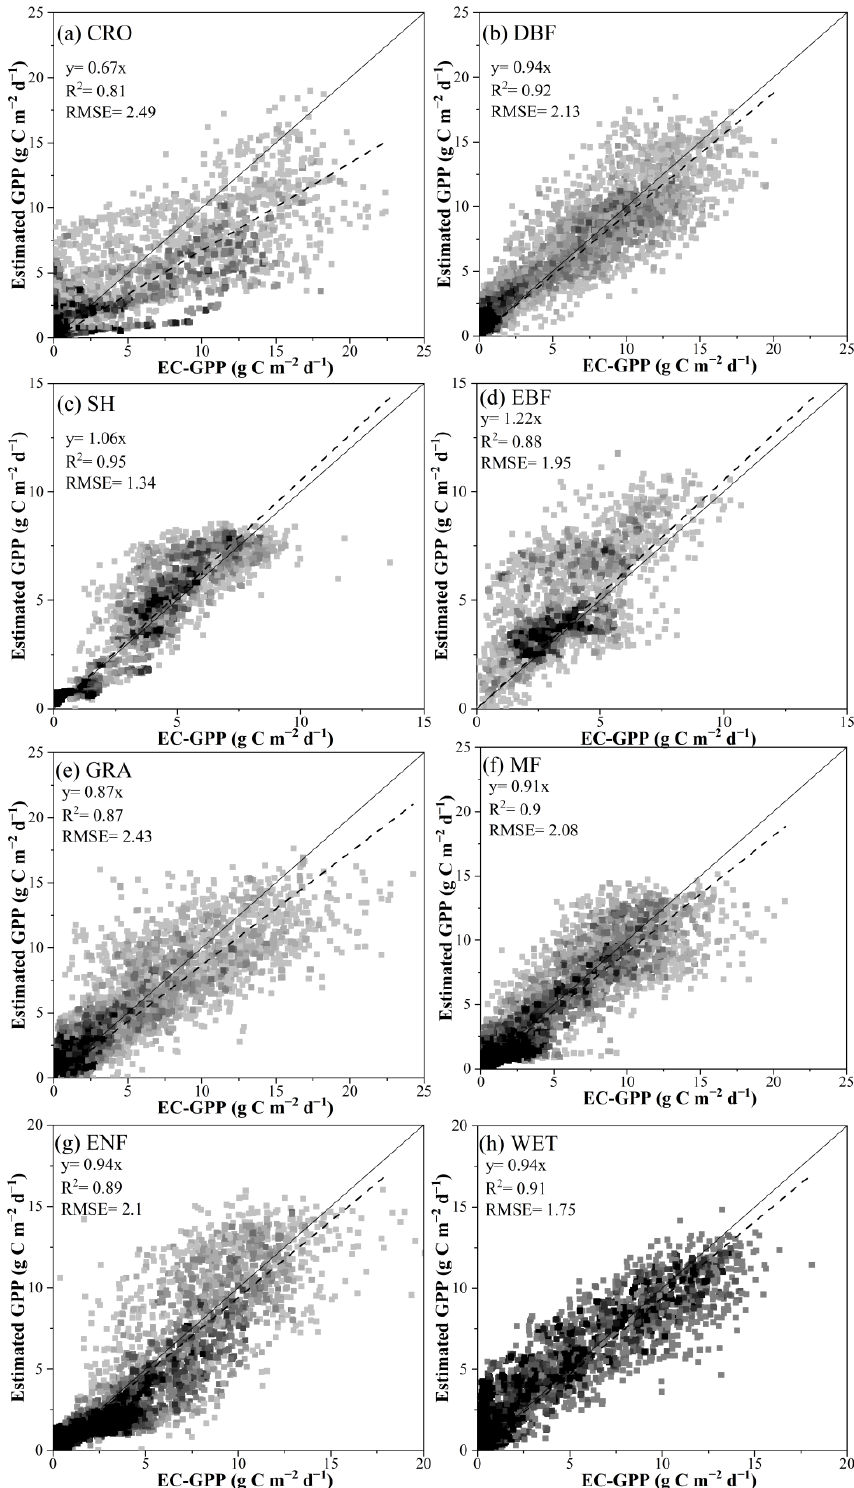
Figure 3. Model calibration accuracy for nine PFTs: ( a ) CRO, ( b ) DBF, ( c ) SH, ( d ) EBF, ( e ) GRA, ( f ) MF, ( g ) ENF, and ( h ) WET. The R 2 , RMSE, and slope were estimated from the regression of the modeled GPP and EC-GPP for each biome with the intercept forced to 0. Biome abbreviations are given in Figure 2. The gray dots represent simulations constrained by seasonal dynamic V cmax using the “All” model simulations (dots in pink circles). The dashed and solid lines are the regression line and 1:1 line, respectively.